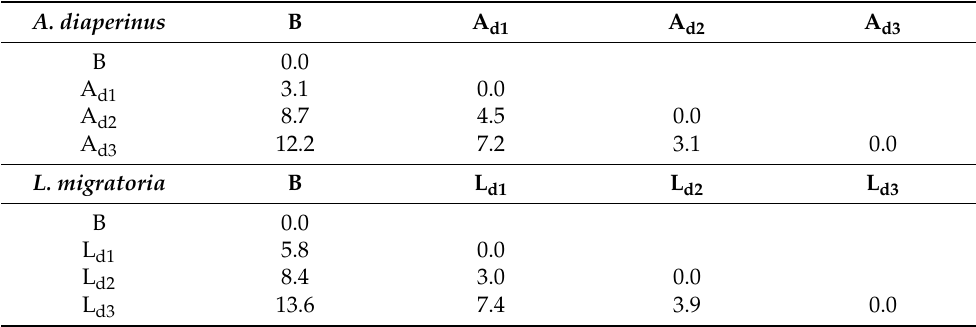
Table 4. Soft independent modeling of class analogy interclasses distances from the 4-class SIMCA A. diaperinus doughs model and the 4-class SIMCA L. migratoria doughs model.